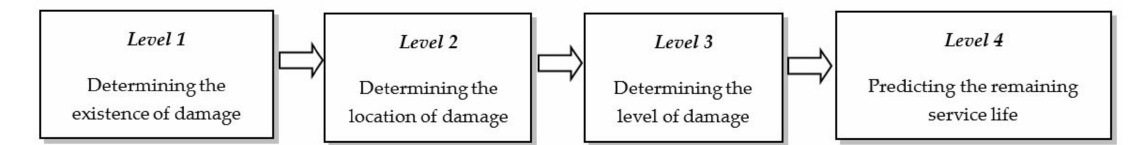
Figure 3. Demonstration of the damage determination system according to